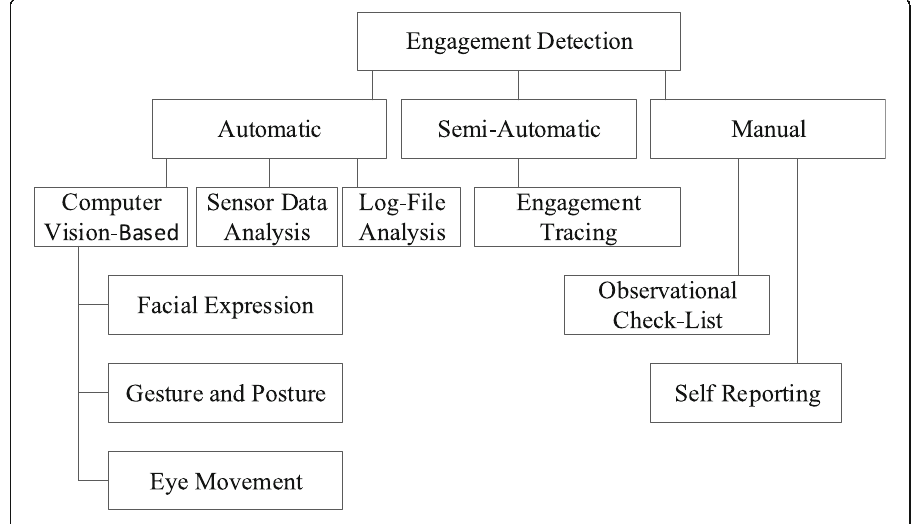
Fig. 1 Taxonomy of learners ’ engagement detection